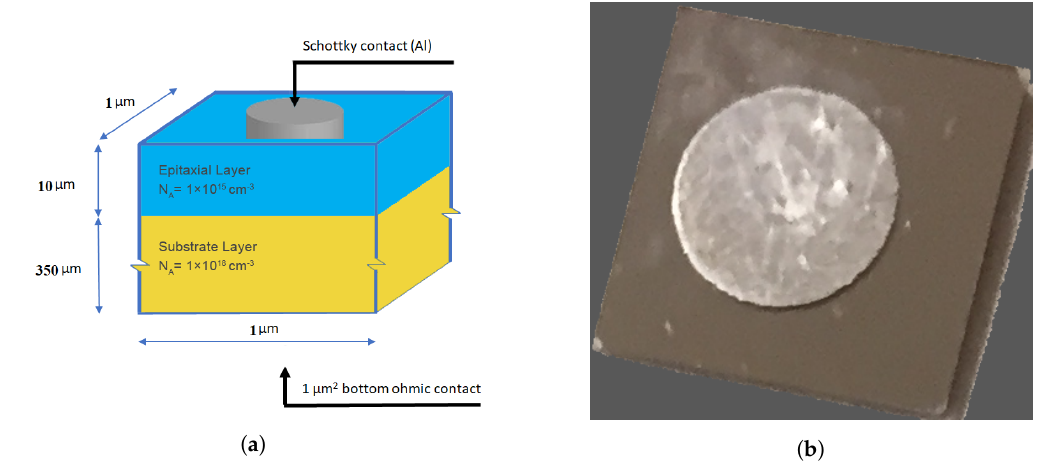
Figure 1. Illustration of the structure of a Schottky barrier diode. ( a ) Schematic of the fabricated device structures and doping concentration of Schottky barrier diodes. ( b ) Physically fabricated diffusion welded Schottky barrier